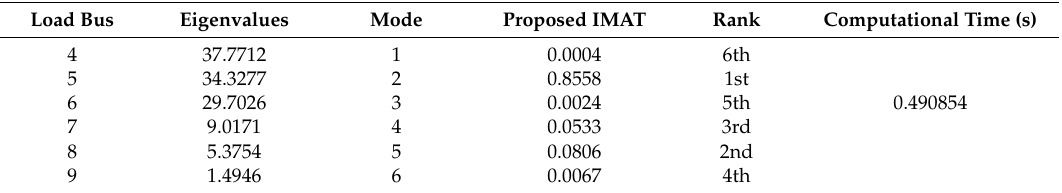
Table 4. Results of the Proposed improved modal analysis technique (IMAT) of the WSCC 9-bus power system.